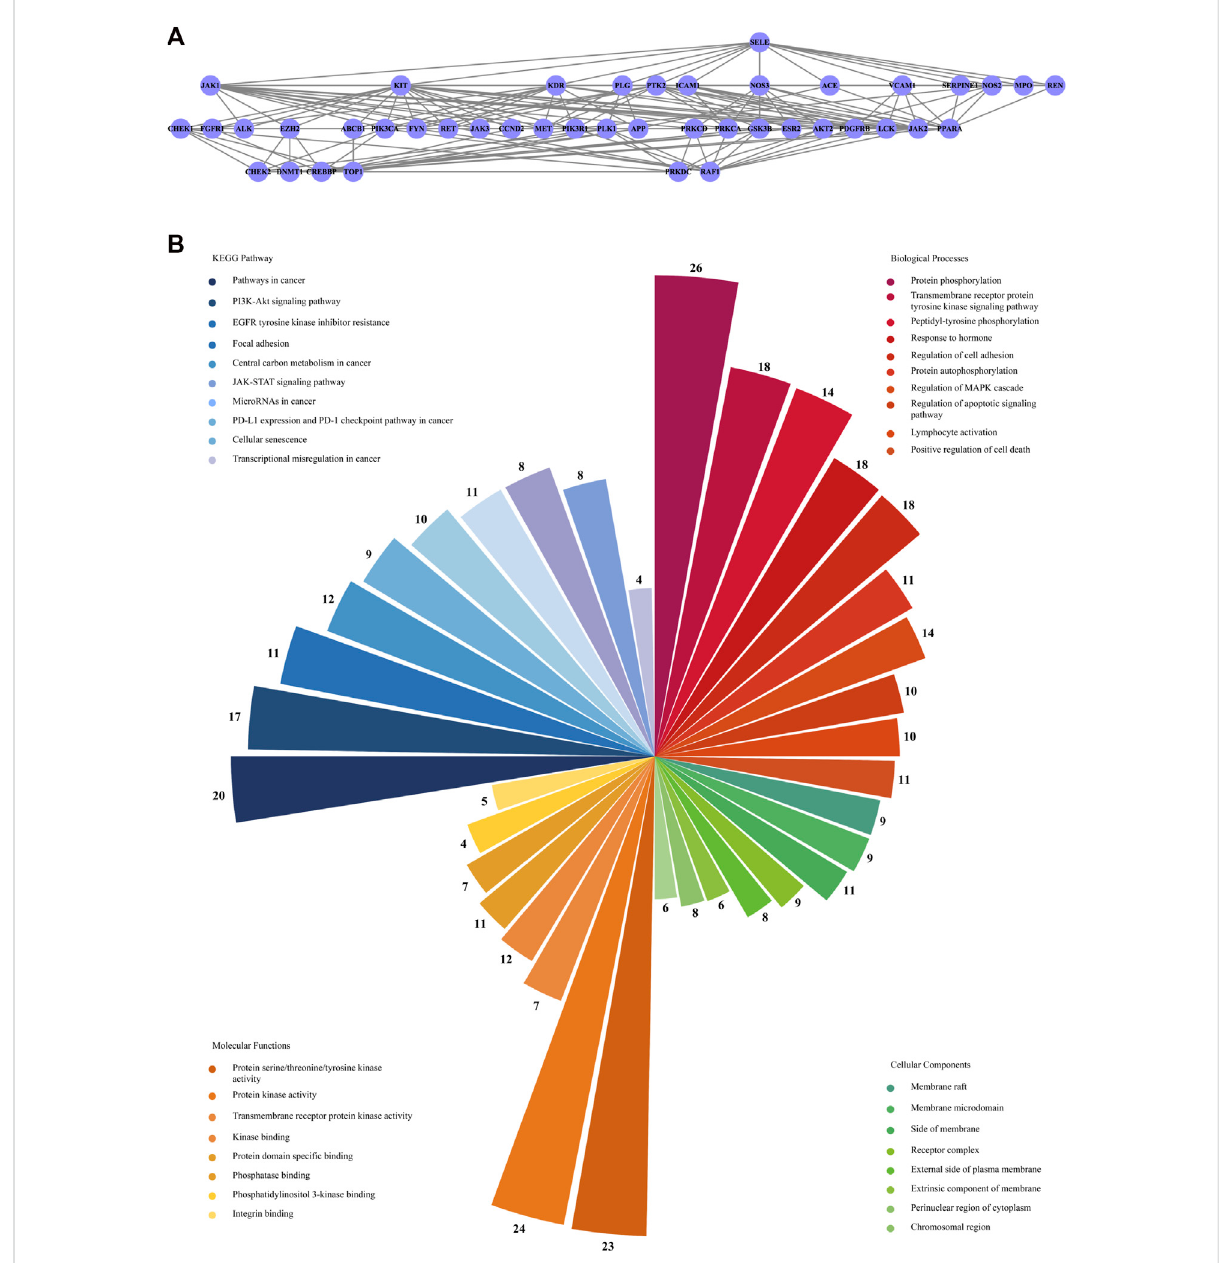
FIGURE 6 Composition and enrichment analyses of Cluster Two (A) Cluster Two had 43 nodes and 261 edges with a MCODE score of 12.43 (B) Signi fi cantly enriched GO BP/CC/MF terms and KEGG pathways of Cluster Two were displayed in the Nightingale rose diagram, with the number above each petal representing the gene count enriched in this term. The larger the petal, the lower the adjusted p -value (all the adjusted p -value were under